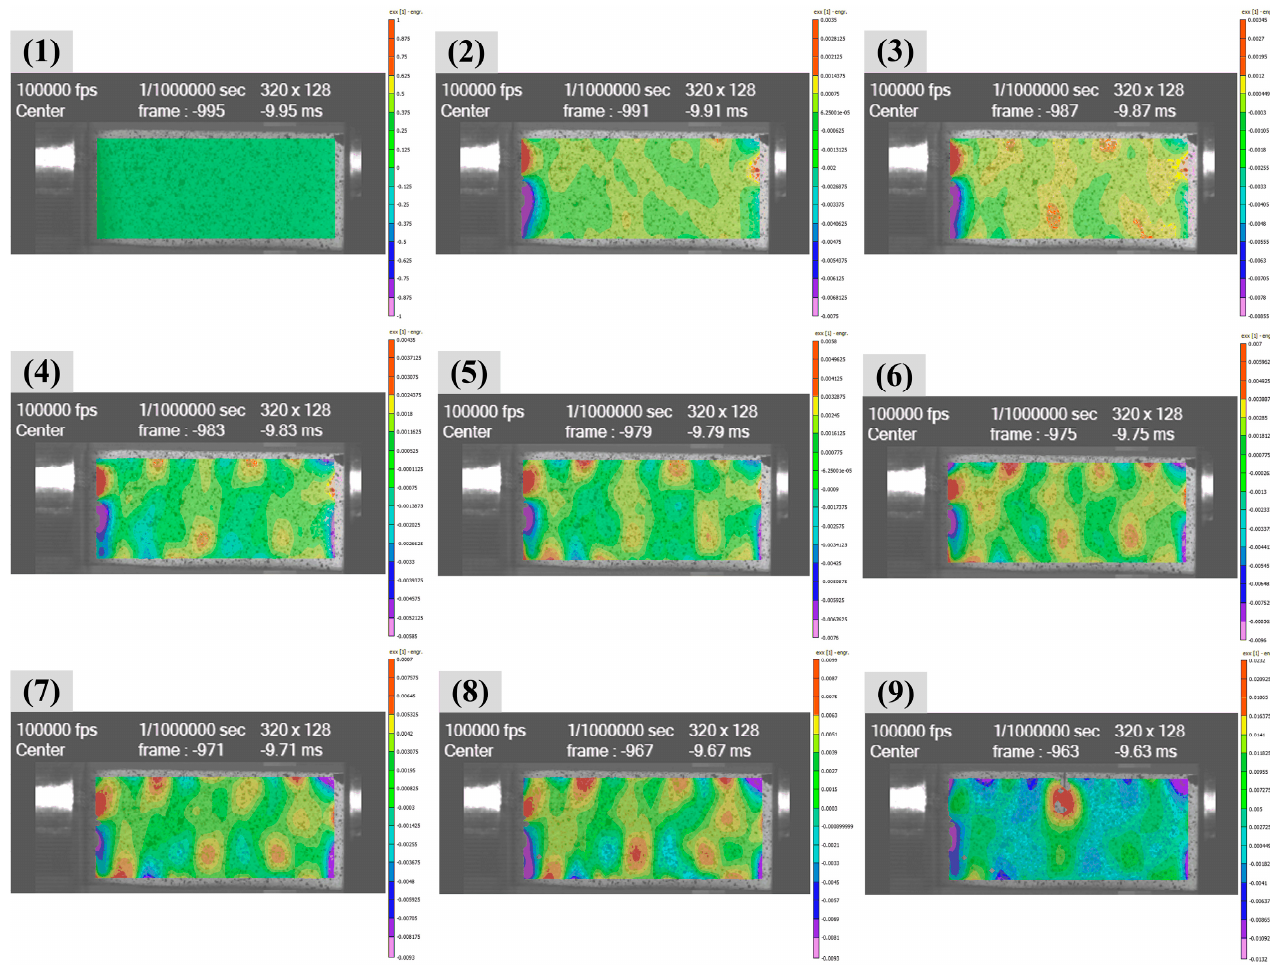
Table 1. Ultimate stress and strain of neat benzoxazine and ABP under different strain rates.